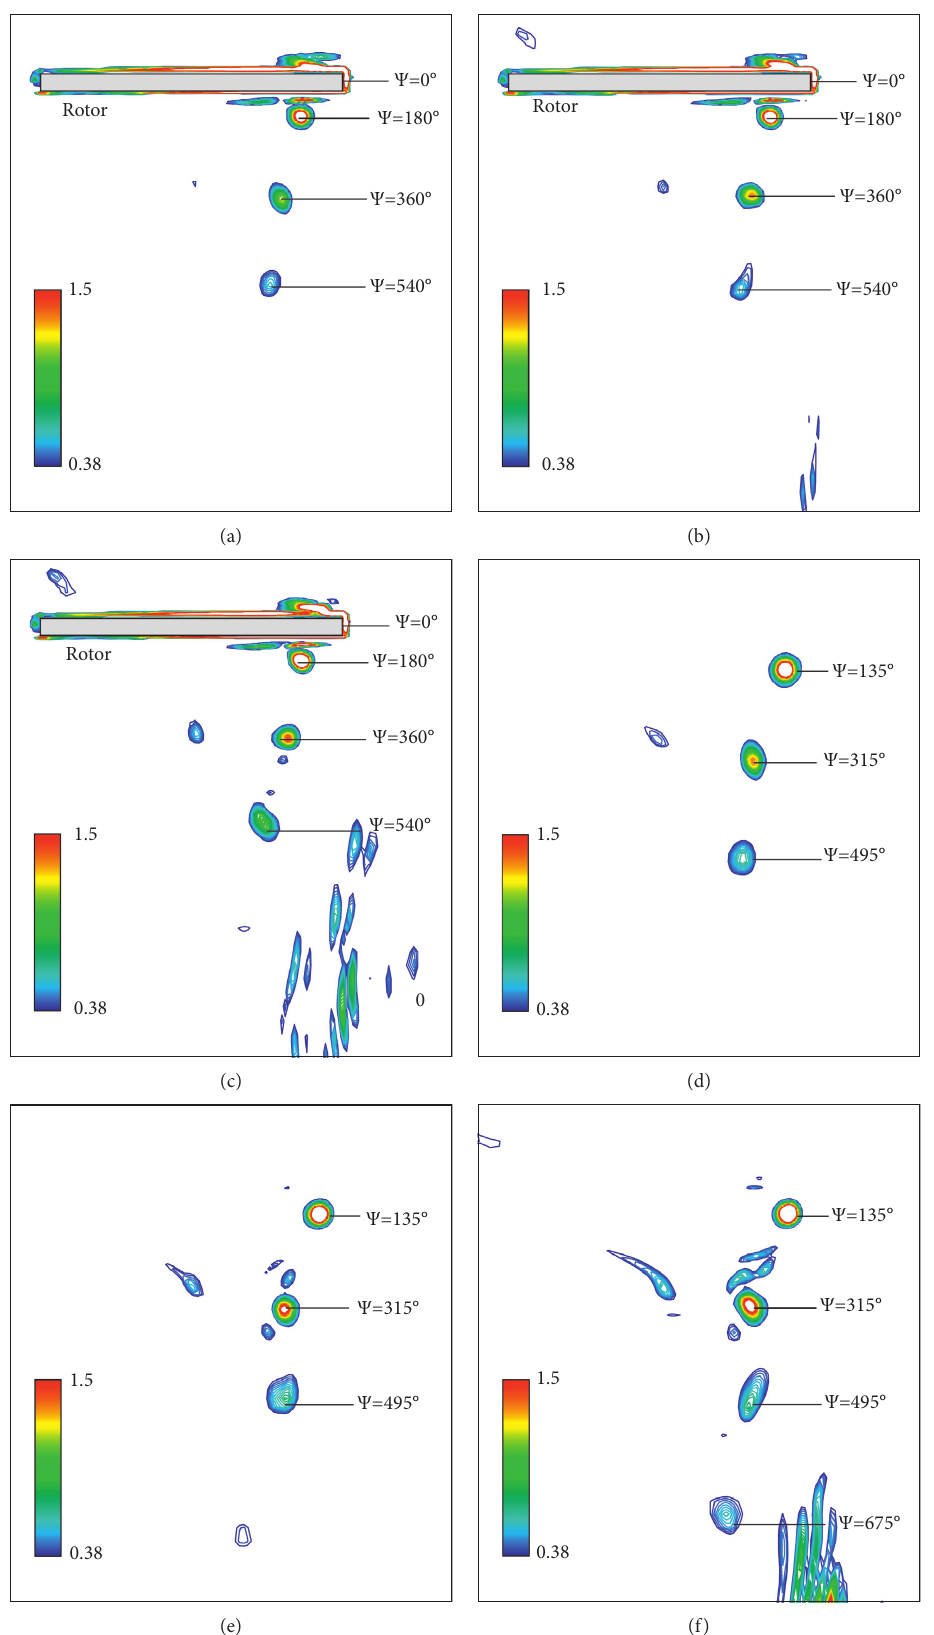
Figure 19: Vorticity contours with three WENO schemes for Caradonna-Tung rotor. (a) WENO-JS. (b) WENO-Z. (c) WENO-NZ. (d) WENO-JS. (e) WENO-Z. (f)